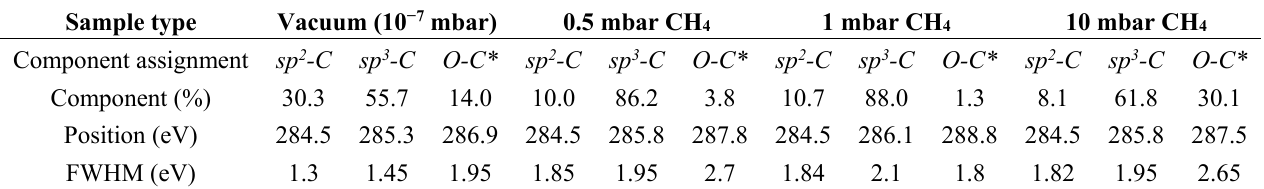
Table 3. X-ray photoelectron spectroscopy (XPS) peak separation data for C1s line of DLC